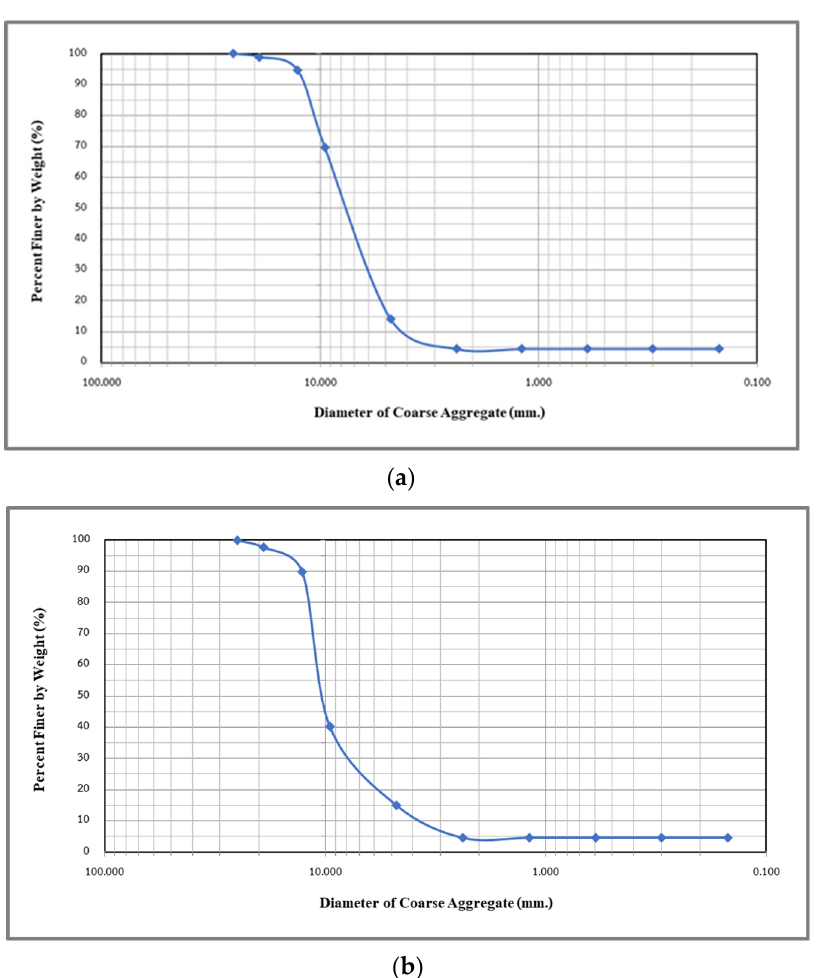
Figure 3. Results of sieve analysis on ( a ) recycled coarse aggregates and ( b ) natural coarse aggre ‐ gates.